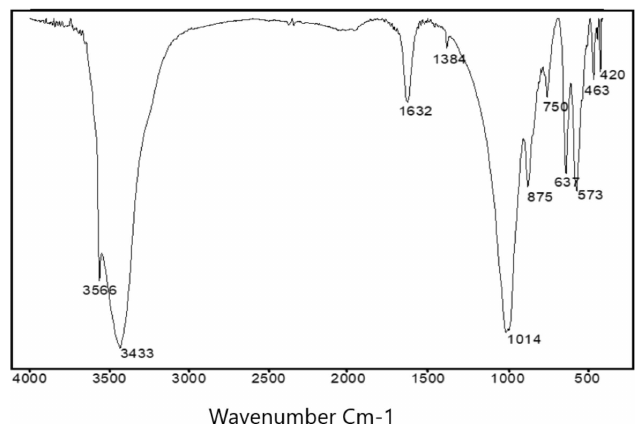
Figure 6 Infrared spectrum of SrCo 4 (OH)(PO 4 ) 3